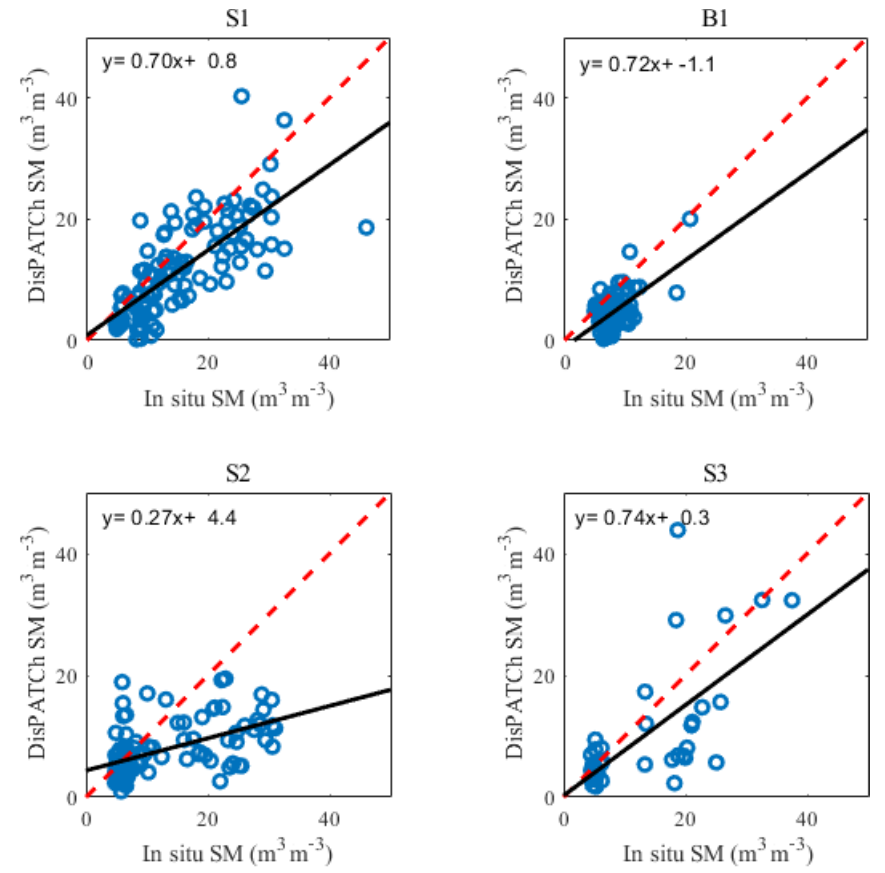
Figure 3. Scatterplots of the 1km resolution DisPATCh versus in situ SM at the Sidi Rahal site for the S1 (2014–2015), B1 (2015–2016), S2 (2016–2017) and S3 (2017–2018) agricultural seasons,